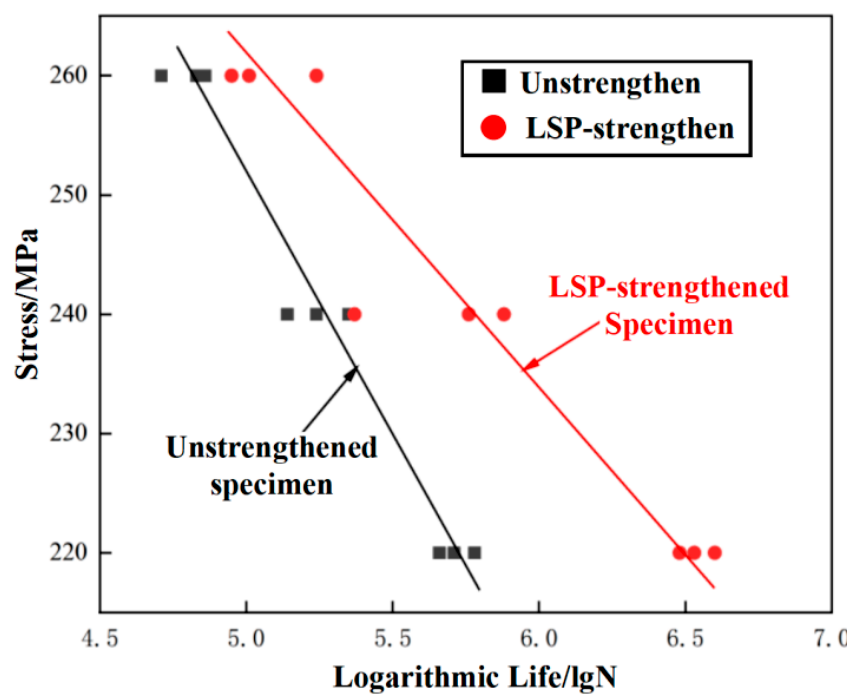
Figure 7. Comparison of the fatigue life of the 7B04 aluminum alloy before and after impact strengthening.